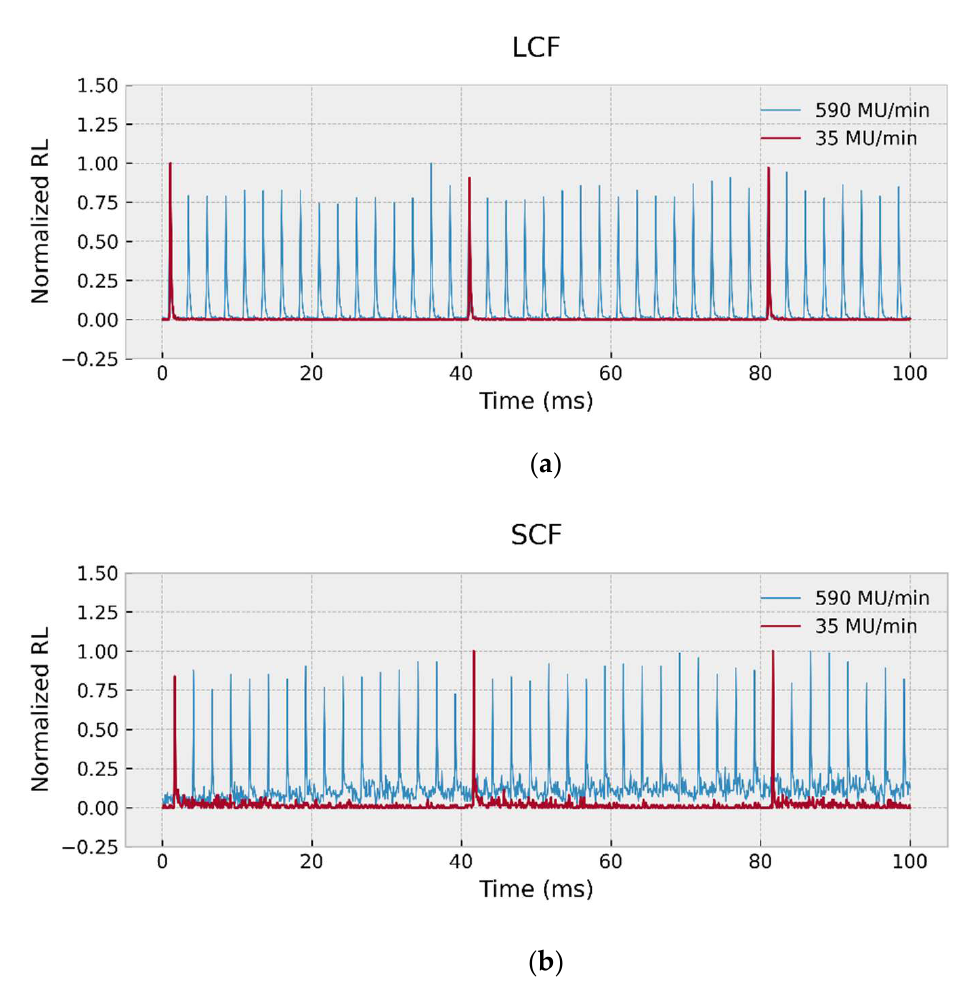
Figure 11. Pulse train of the RL response (gate time of 100 μs) at 35 MU/min and 590 MU/min for ( a ) LCF and ( b ) SCF, highlighting the long phosphorescence presence in SCF. Values are normalized to the highest y-axis value for the datastream.